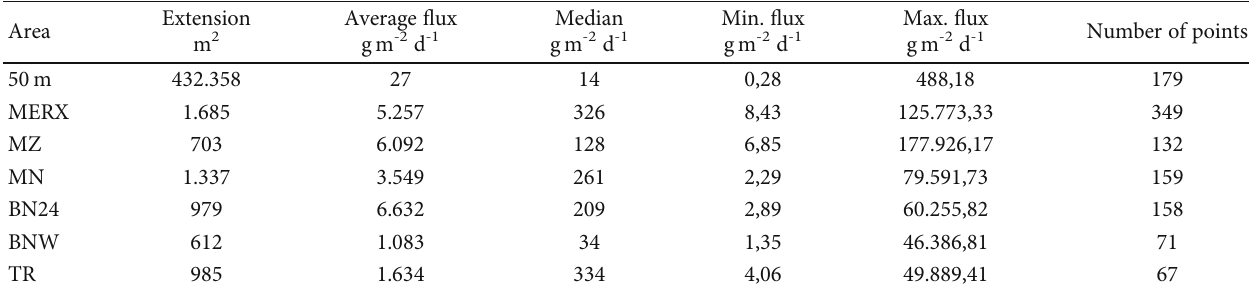
Figure 7: Soil CO gas fl ux for (a) BN24, (b) BNW, and (c) TR. Left: October 2018 drone image with partitioned populations. Right: August 2 2017 drone image. Table 6: Main parameters of the surveyed